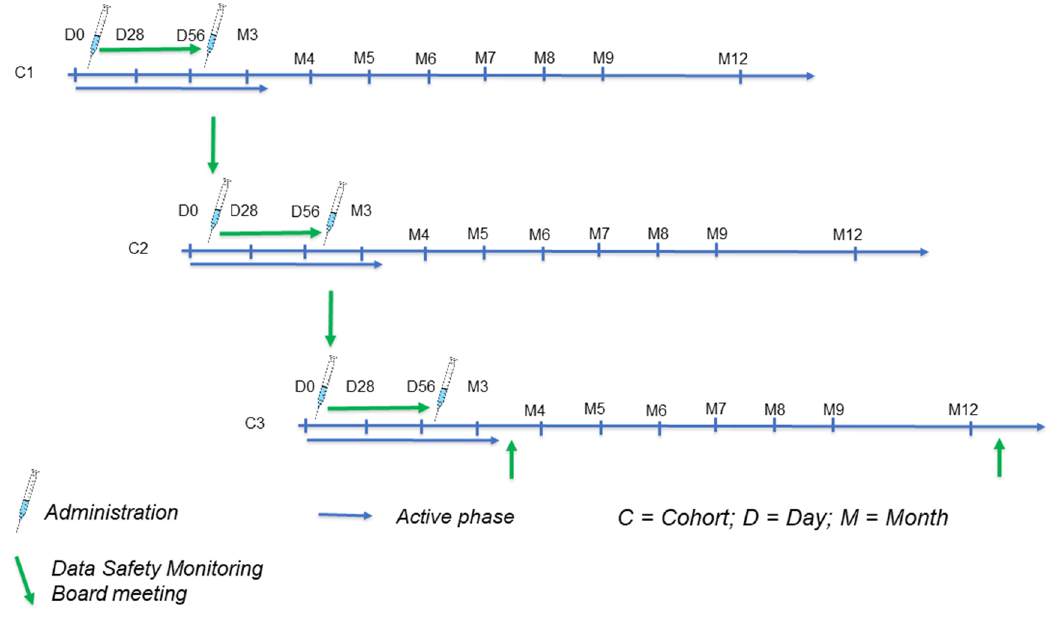
Figure 1. Clinical study